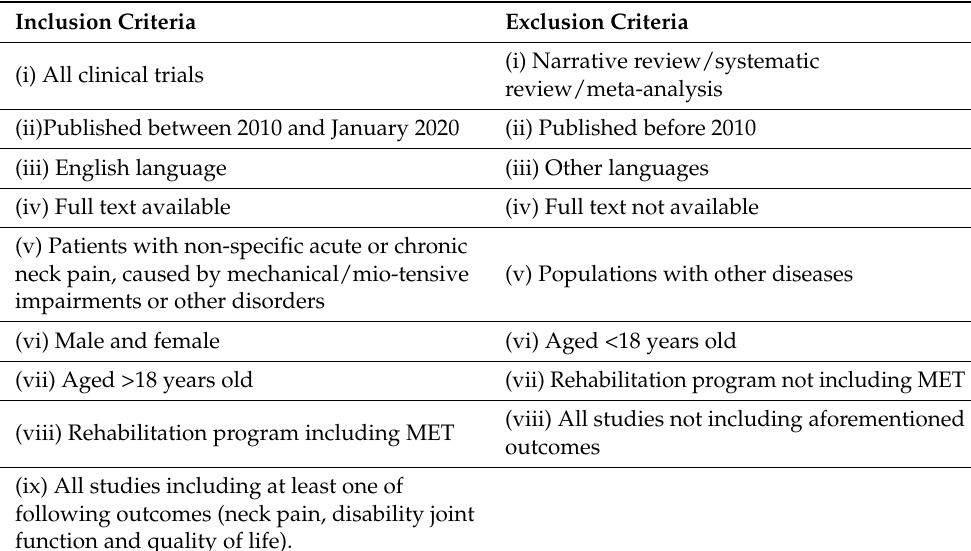
Table 1. Inclusion and exclusion criteria used for paper selection. Inclusion